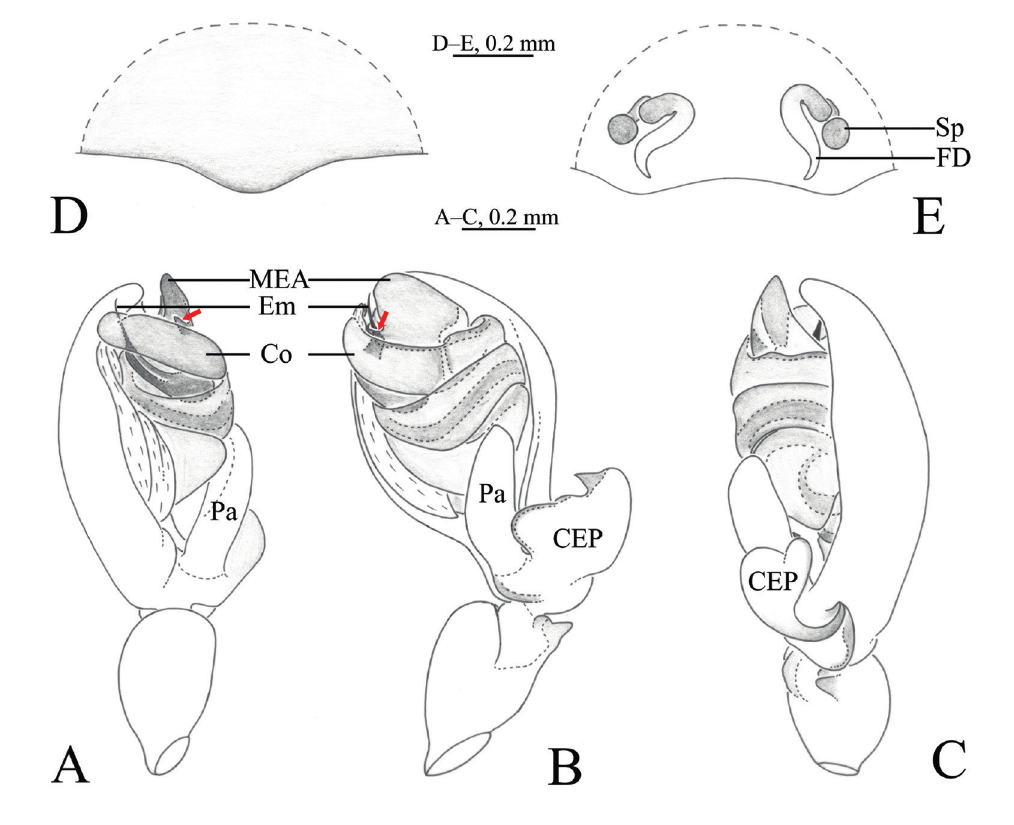
Fig. 5. Meta cona sp. nov. A–C . ♂, holotype (SWUC-T-TEg-03-01). D–E . ♀, paratype (SWUC-T- TEg-03-02). A . Left palp, prolateral view. B . Same, ventral view. C . Same, retrolateral view. D . Epigyne, ventral view. E . Vulva, dorsal view. A–B . Red arrow indicating the lower outgrowth of metaine embolic